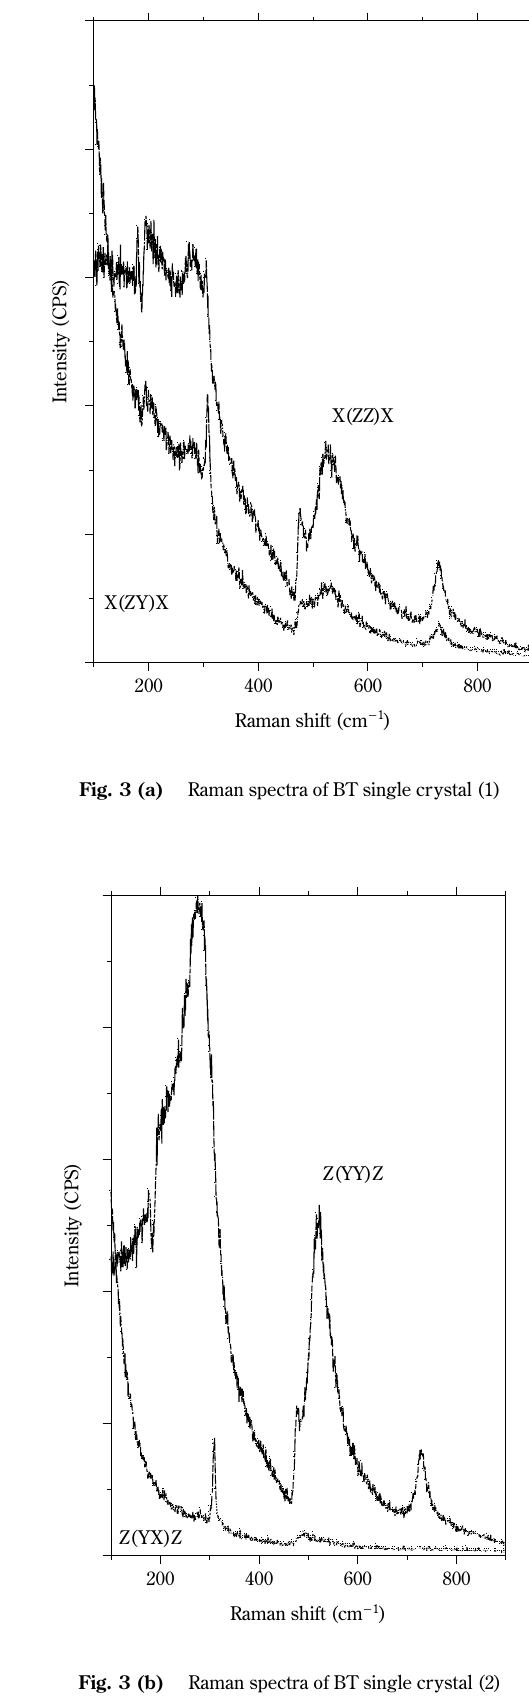
Fig. 3 (b) Raman spectra of BT single crystal (2)